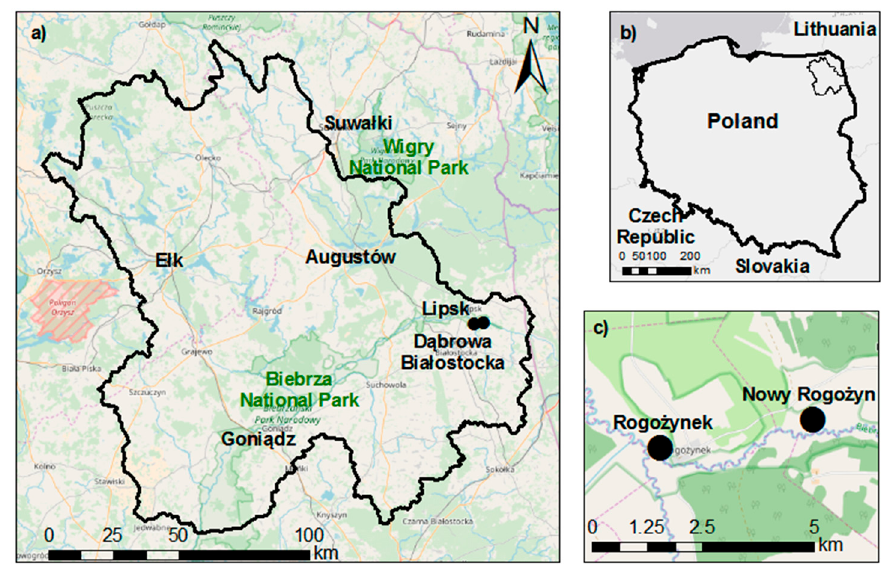
Figure 1 . Study site area ( a ) location of study sites in Upper Biebrza Basin; ( b ) location of Upper Biebrza Basin in Poland; ( c ) exact location of two measured meadows.